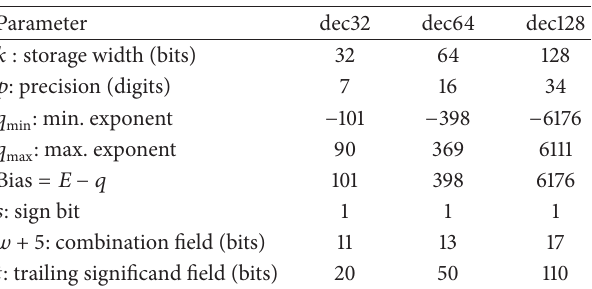
Figure 1: Decimal interchange formats [4]. Table 1: Interchange format parameters